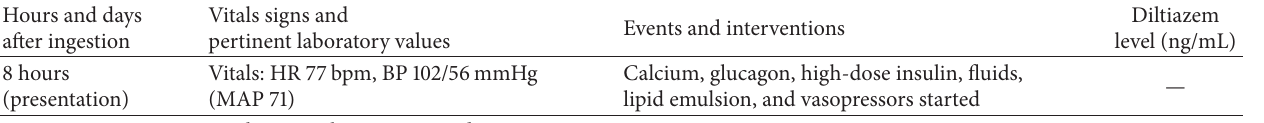
Table 1: Vital signs and laboratory measures and events during the